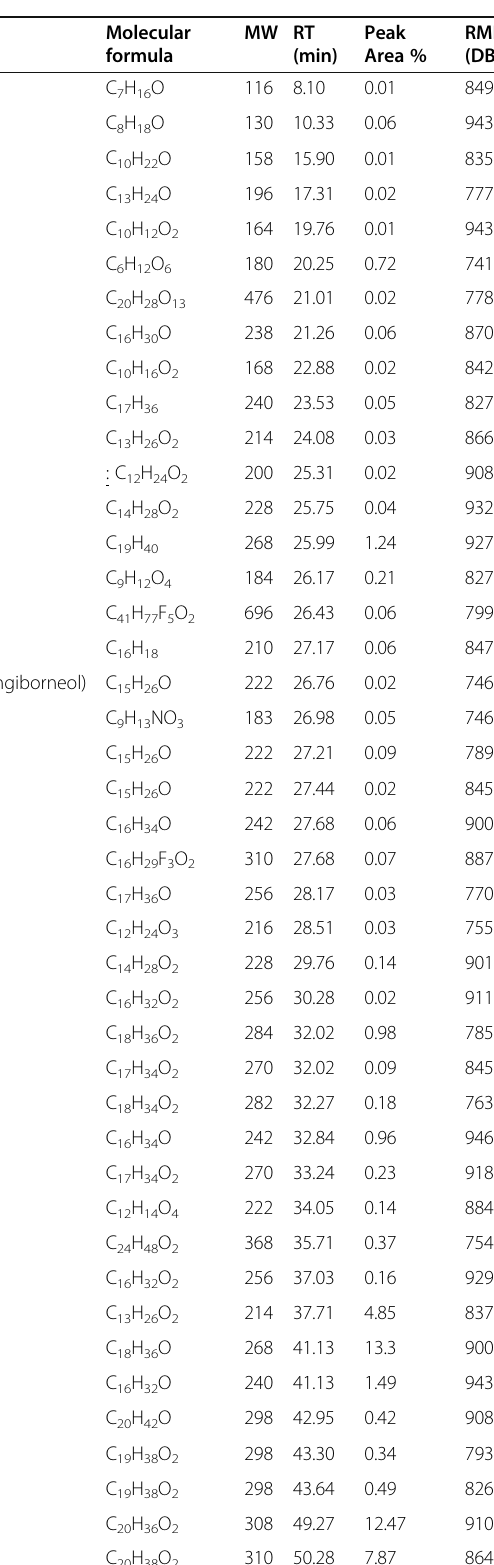
Table 3 Compounds identified in Spondias mombin stem bark